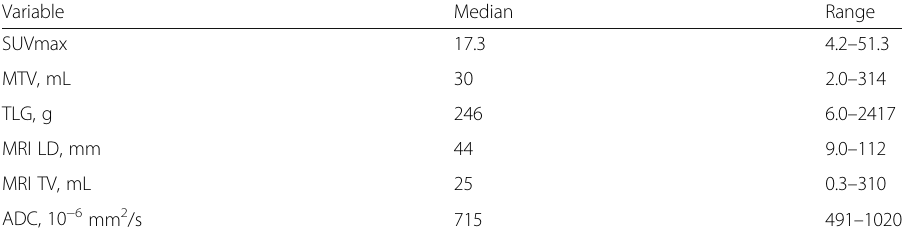
Table 2 Median (range) tumour values of FDG-PET/CT and MRI parameters Variable Median Range SUVmax 17.3 MTV, mL